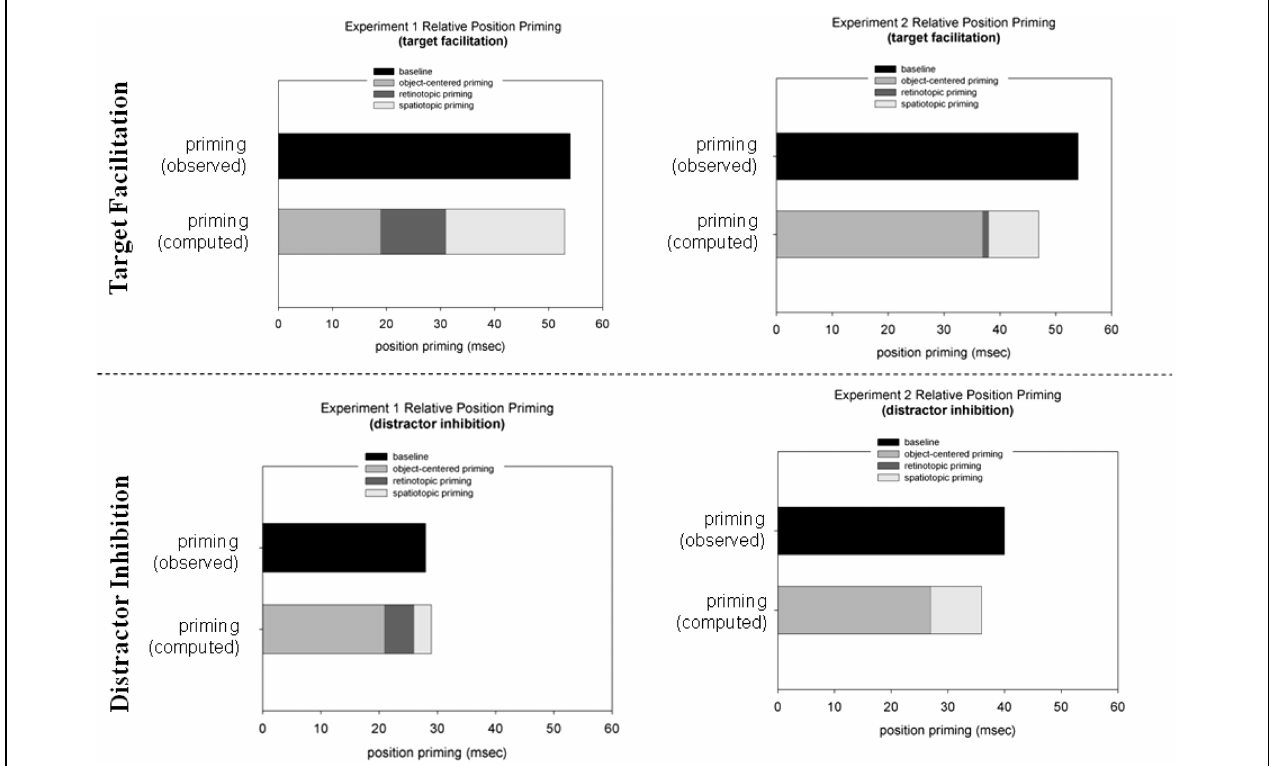
FIGURE 4 | Target location facilitation reaction time (RT target-at-target minus RT target-at-neutral location; upper panel; in ms) and distractor location inhibition (RT target-at-distractor minus RT target-at-neutral location; lower panel; in ms) in Experiments 1 (left panel) and 2 (right panel). The black bars represent the obtained priming effects in the baseline